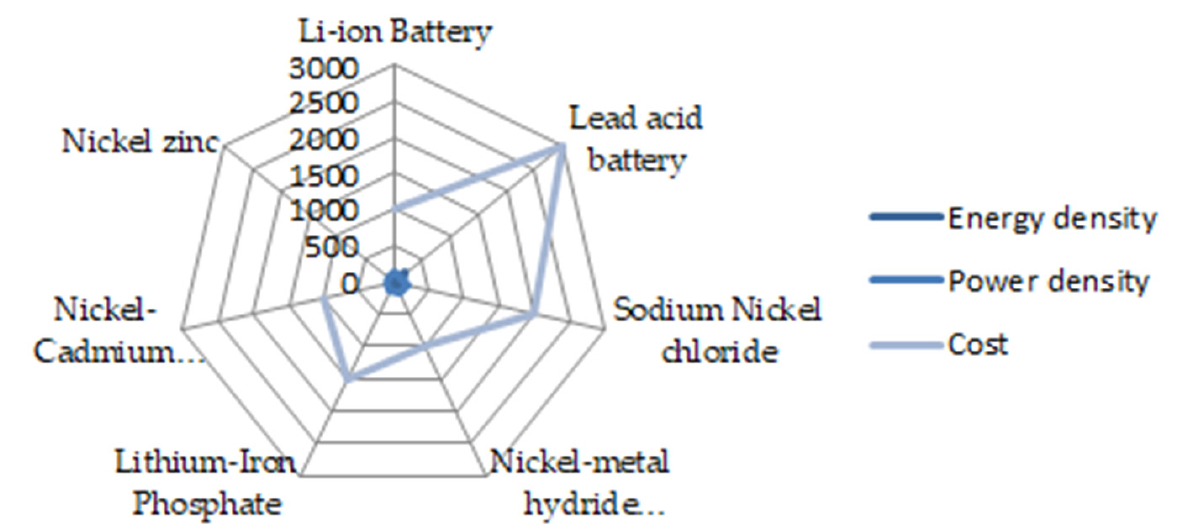
Figure 6. Spiderchart represents the performance comparisons of various batteries. Table 7. Different types of passive batteries employed in EVs.